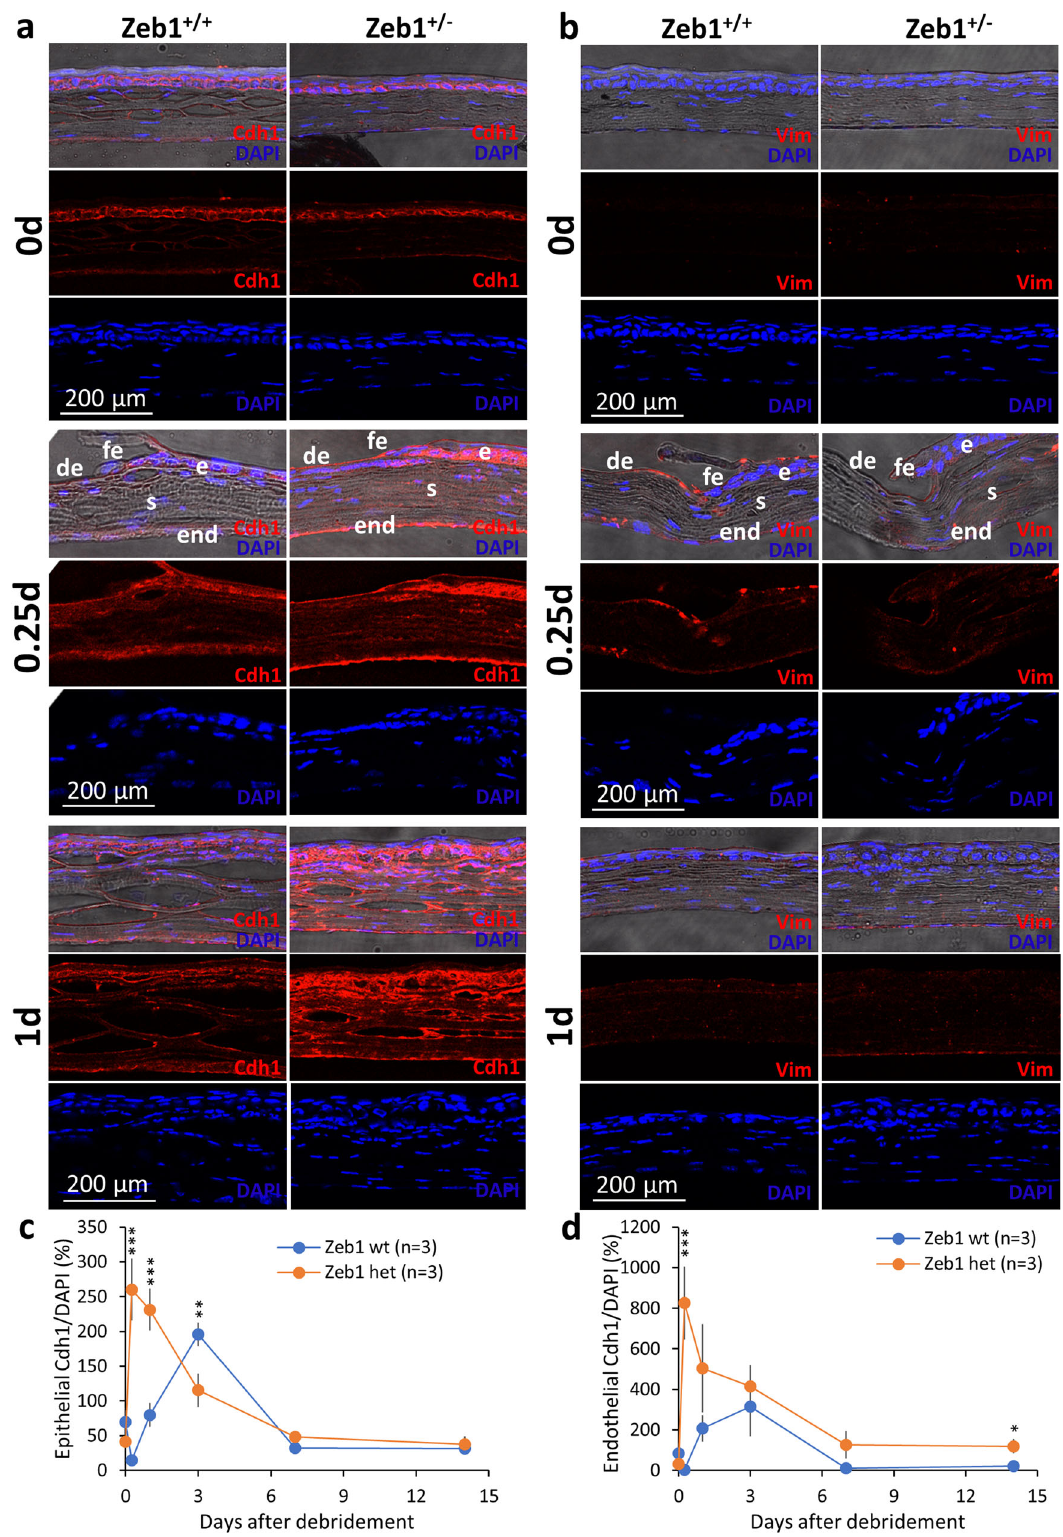
Fig. 5 Monoallelic Zeb1-KO inhibits corneal epithelial EMT. The representative images of a Cdh- and b Vim-stained cryosections of both Zeb1 + / + and Zeb1 + / − corneas before (0 day) and after the epithelial debridement. The amounts of Cdh1 per DAPI unit detected by immunohistochemistry and measured by ImageJ in c the epithelium and d the endothelium before (0 day) and after the epithelial debridement. wt, Zeb1 + / + ; het, Zeb1 + / − ; de, de- epithelialized; fe, front edge of the debrided epithelium; e, the epithelium; s, the stroma; end, the endothelium; * p ≤ 0.05; ** p ≤ 0.01; *** p ≤ 0.001. The error bars are the standard deviation (SD)